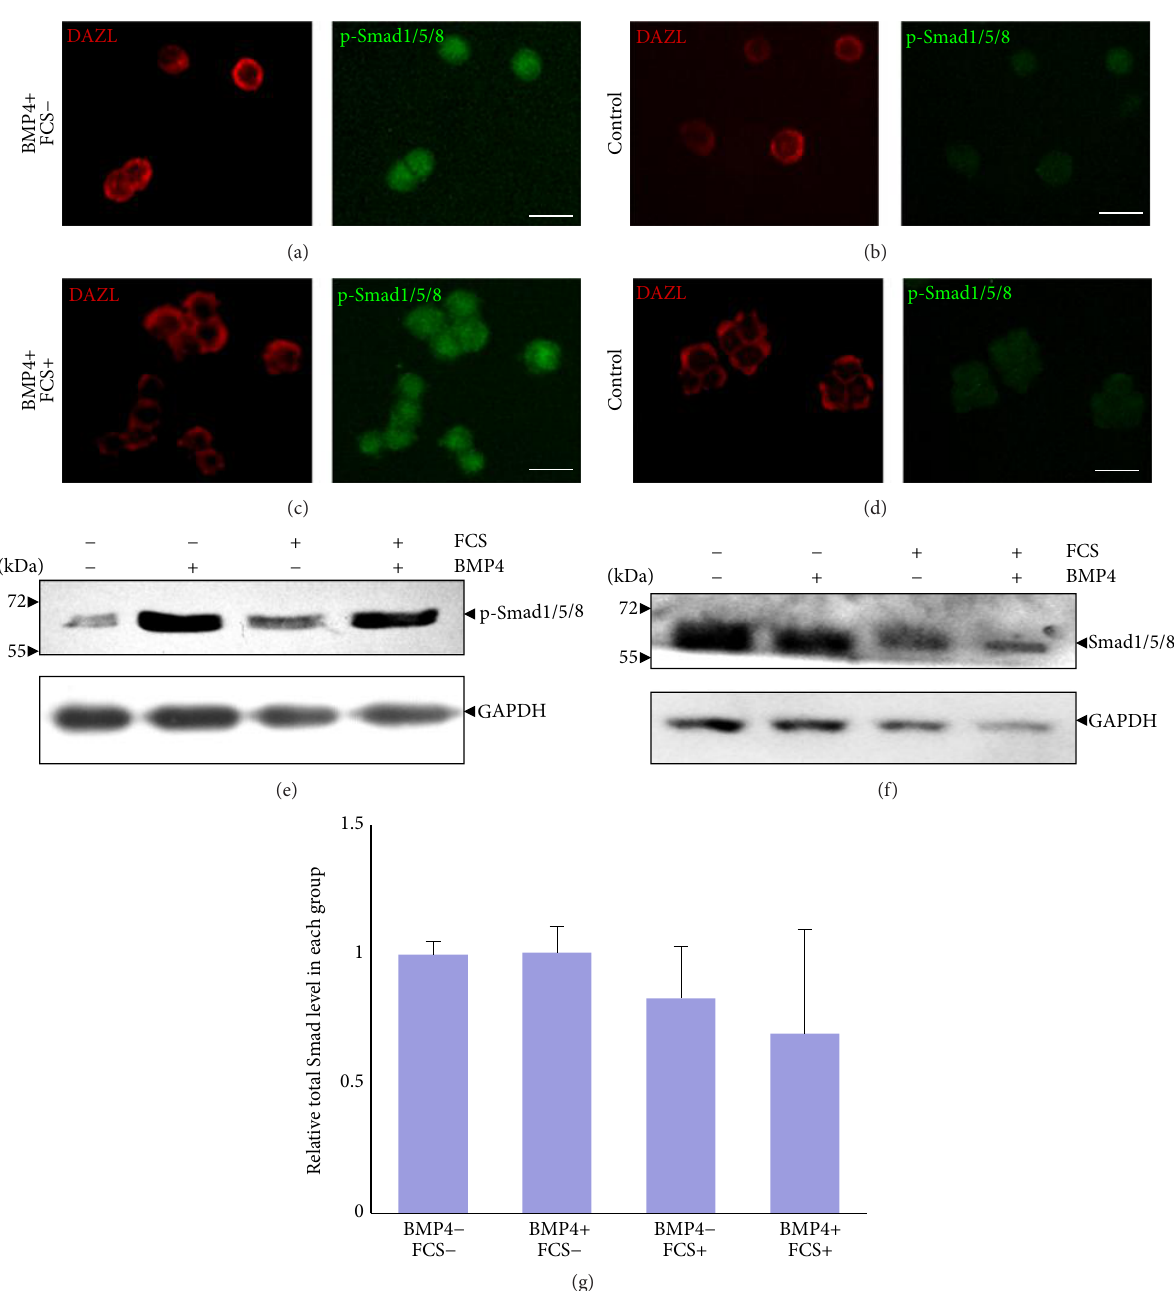
Figure 5: BMP4 activates Smad signalling pathway in cultured spermatogonia. (a-b) IFA analyses of spermatogonia cultured in serum-free medium using antibodies against phosphorylated Smad1, Smad5, and Smad8 in the presence of BMP4 (a) or control (b). (c-d) IFA analysis of spermatogonia cultured in 15% serum-containing medium in the presence of BMP4 (c) or control (d). (e-f) Western blotting analysis of phosphorylated (e) and total (f) Smad1/5/8 in spermatogonia under different culture conditions. (g) Relative total Smad1/5/8 level in each group in (f) after normalization to the internal control. Scale bar: 20 𝜇